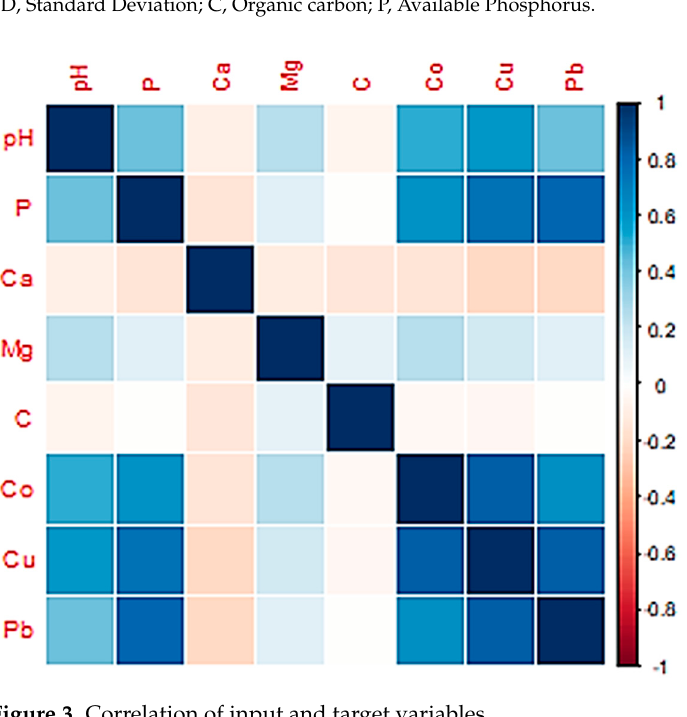
Figure 3. Correlation of input and target variables.